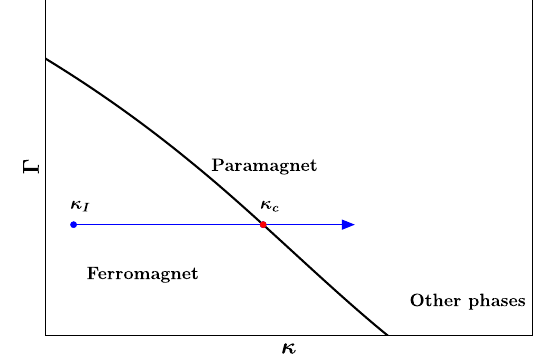
FIG. 1. Schematic representation of our quench protocol, superimposed on a schematic ground-state phase diagram of the ANNNI